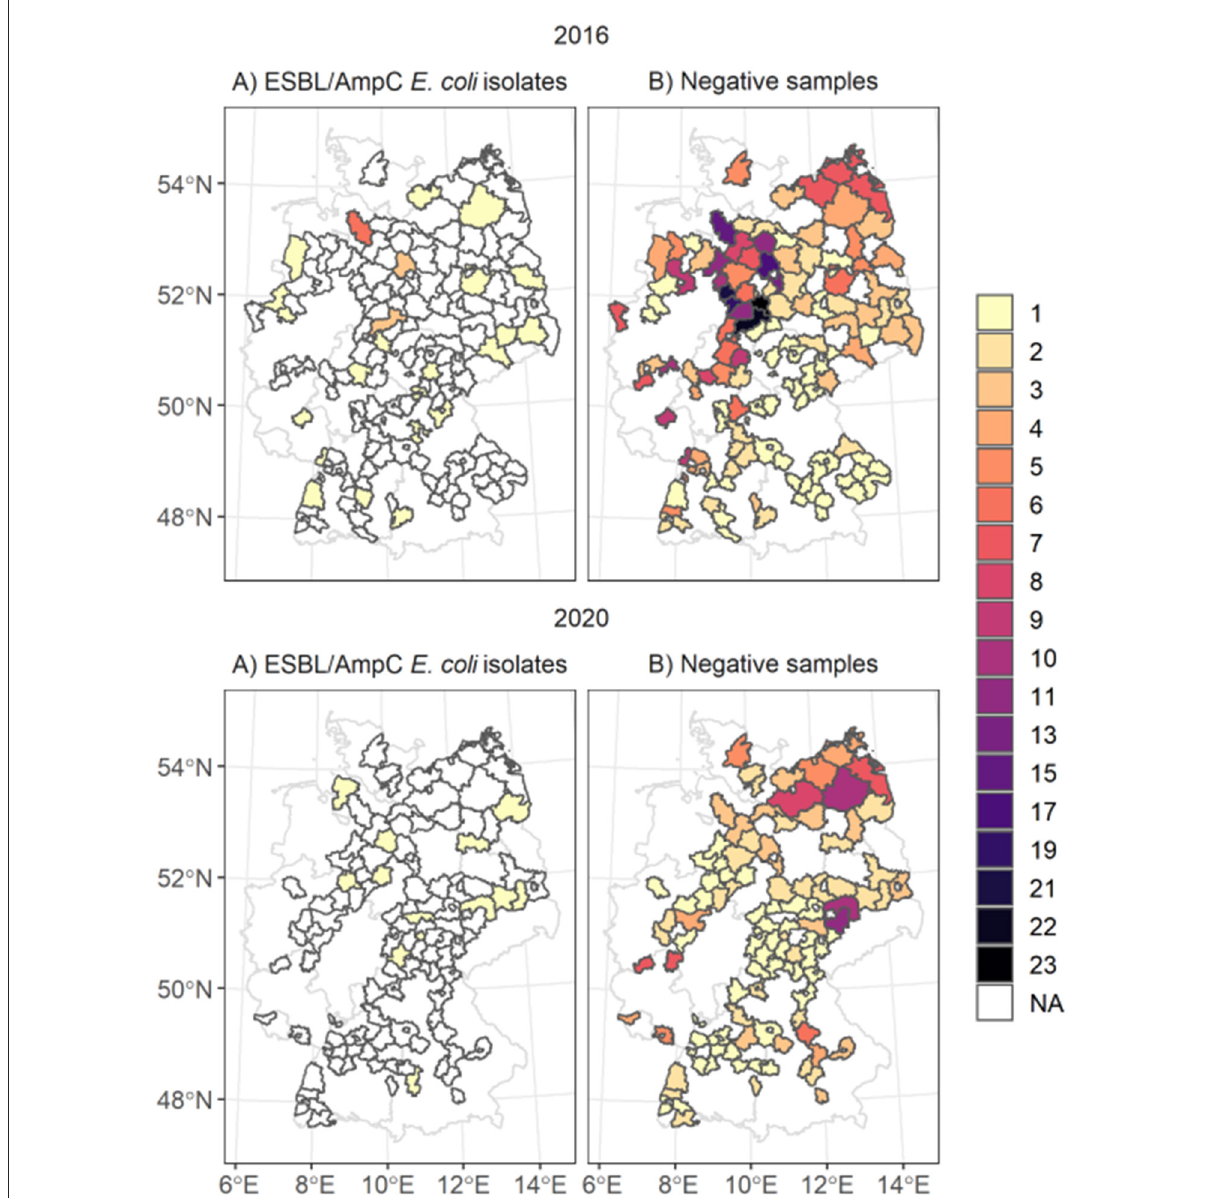
FIGURE1 Spatial distribution of ESBL/AmpC E. coli isolates (map A) and negative samples taken (map B) in the counties. The color of the polygons represents the number of (A) number of isolates taken and in (B) the number of negative samples taken. The white areas marked as NA represent areas with no isolates